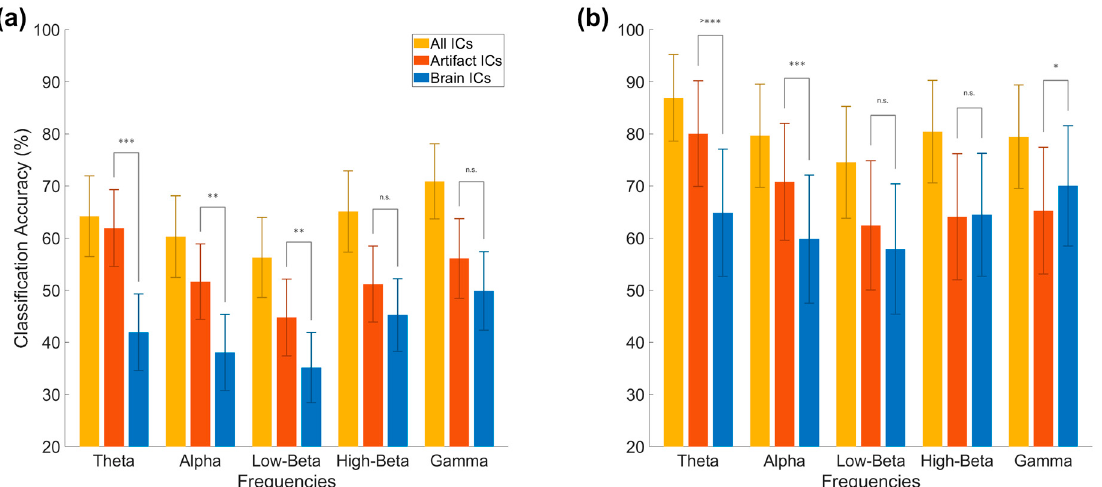
Figure 8. Frequency-based analysis of EEG conditions. Results from the time frequency analysis approach ( a ) and bandpower ( b ) in each of 5 frequency bands. The artifact and brain conditions consisted of 10 ICs. The time frequency approach used 14 features for each frequency; the bandpower approach used 64 features. Significance levels: * < 0.05, ** < 0.01, *** < 0.001, n.s.-non